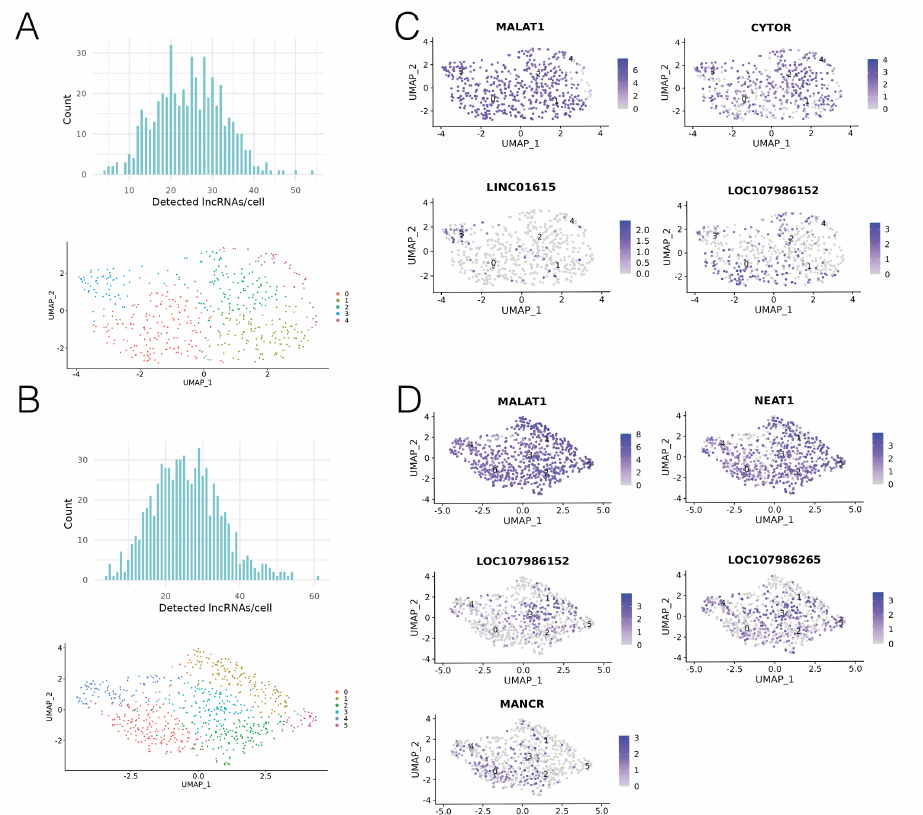
Figure 3. LncRNA expression was heterogeneous in cell line derived xenografts. ( A ) Number of T1 lncRNAs expressed per cell (count = number of cells), UMAP projection of cell clustering, coloured by cluster. ( B ) Number of T2 lncRNAs expressed per cell (count = number of cells), UMAP projection of cell clustering, coloured by cluster. ( C ) T1 upregulated lncRNA expression across cells. Scale = Log2FC. ( D ) T2 upregulated lncRNA expression across cells. Scale =